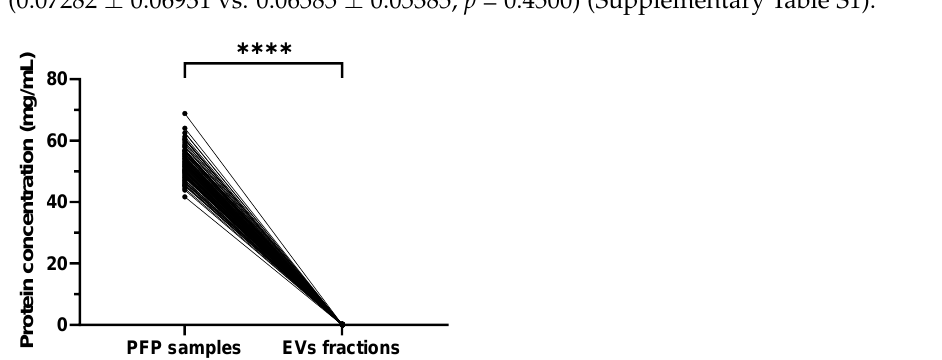
Table 1. Demographic features of the subjects enrolled in the study.